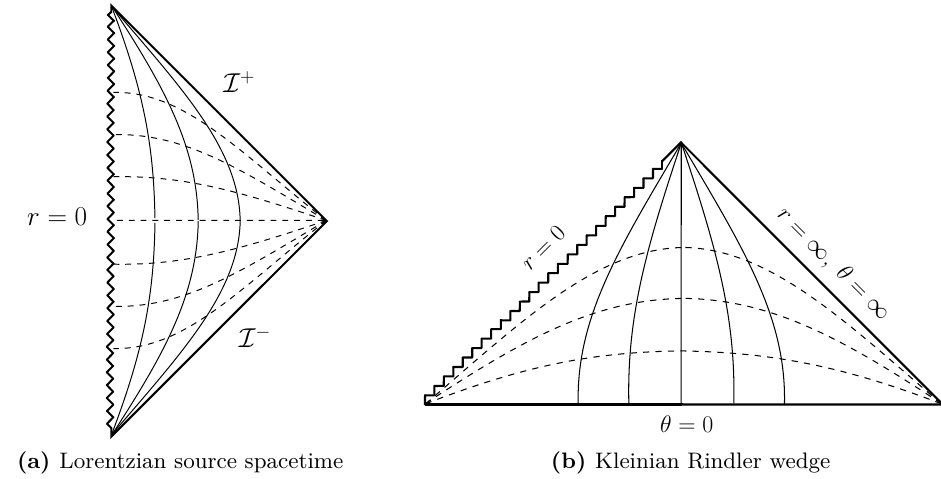
Figure 3. (3a) Shows Lorentzian Minkowski space with a source located at x L = y L = z L =0 (corre- sponding to r = 0 ). Lines of constant r are solid, and lines of constant time are dashed. (3b) Shows the Rindler wedge corresponding to the linearized (2,2) Taub-NUT solution. Lines of constant r are solid, and lines of constant θ are dashed. The singularity is at r = p z 2 − x 2 − y 2 = 0